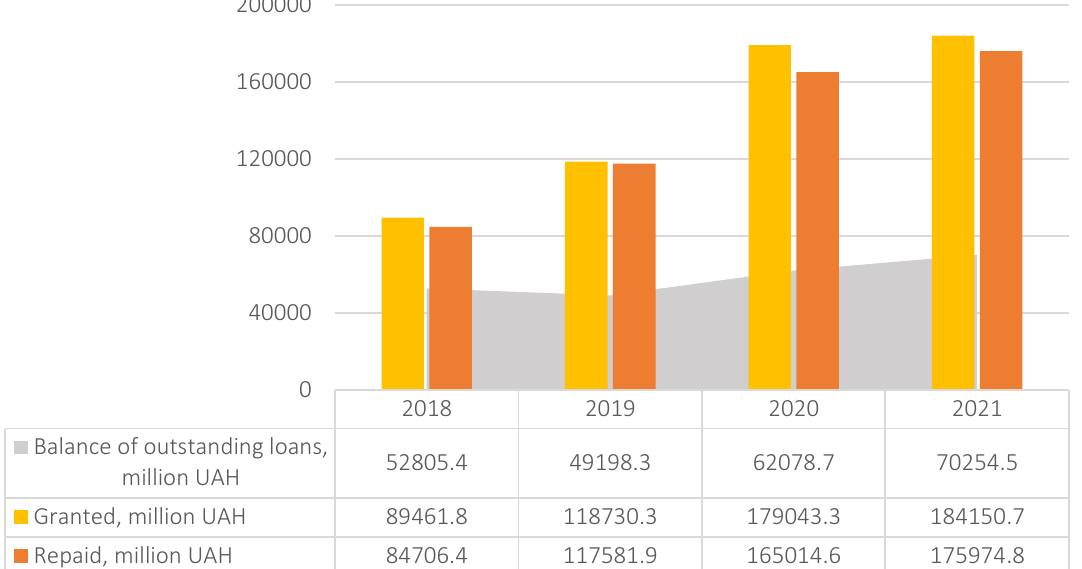
Figure 4. Granting and repayment of loans to cover temporary cash gaps to the Pension Fund of Ukraine related to the payment of pensions from TSA funds, million